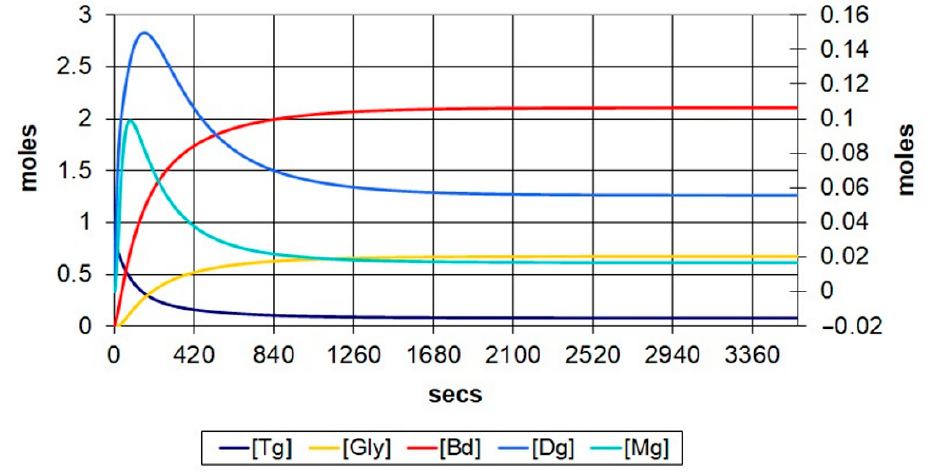
Figure 5. Transesteri fi cation reaction at 60 °C and 6:1 molar ratio.